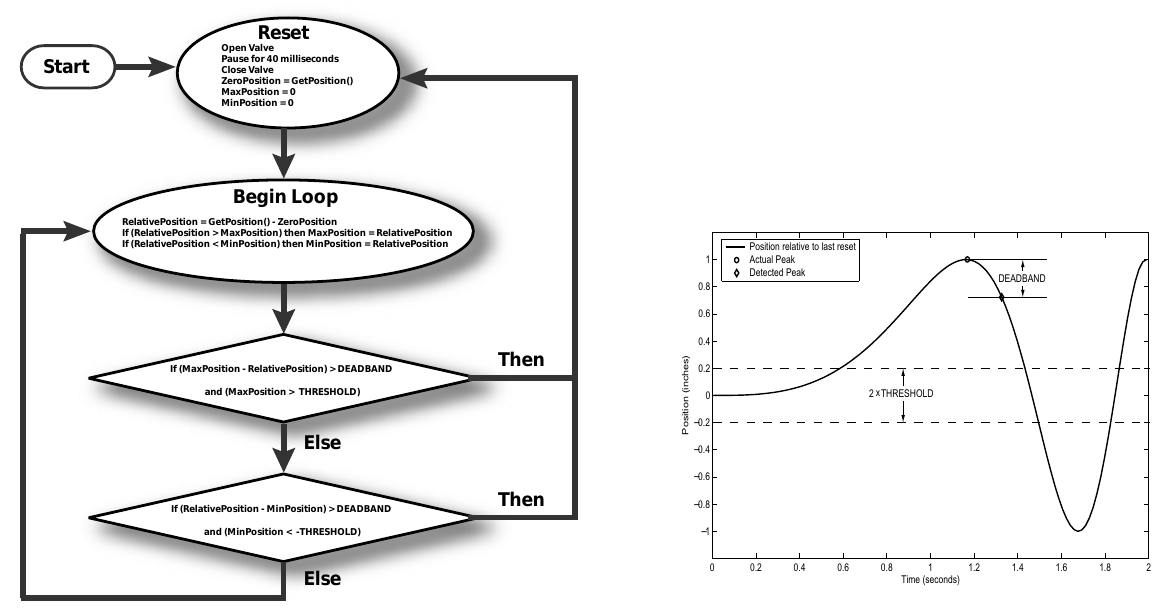
Fig. 5. Flow chart of resetting controller (left) and parameters affecting peak detection logic (right). For this actuator DEADBAND = 0.27" and THRESHOLD =